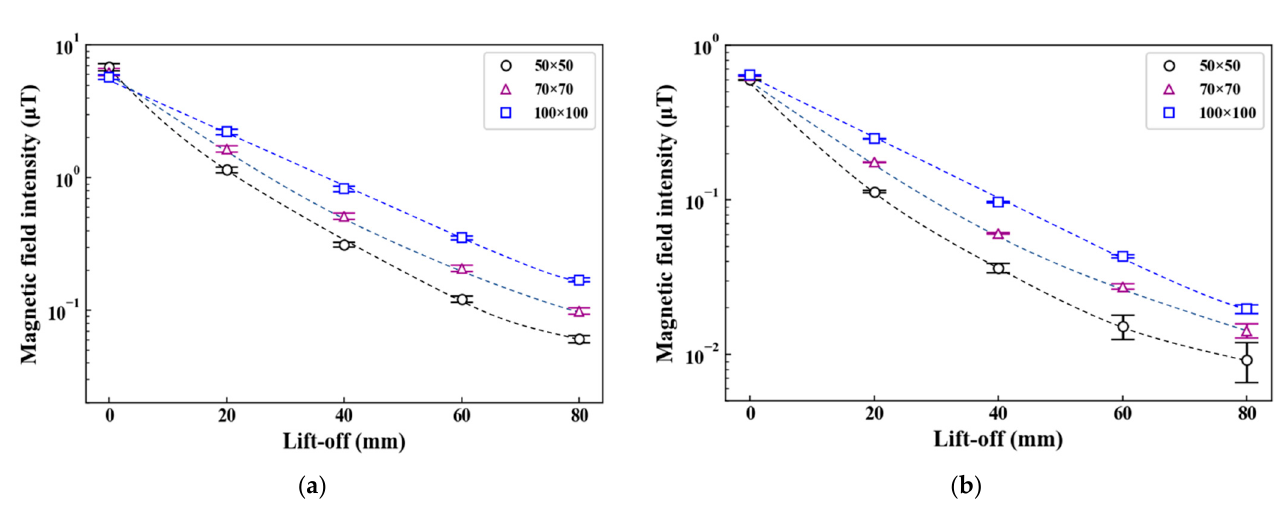
Figure 7. Magnetic field detected at frequencies: ( a ) 1000–3 Hz and ( b ) 20–3 Hz.